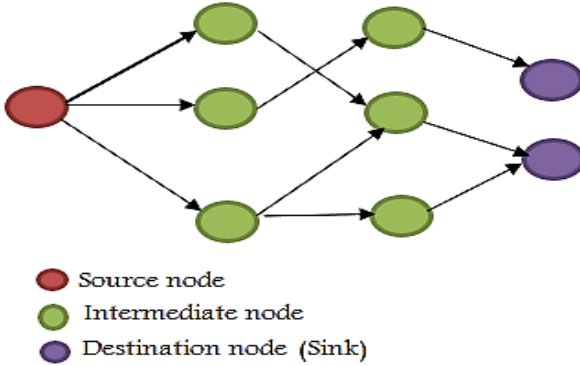
Figure 1. Network model of NC-enabled